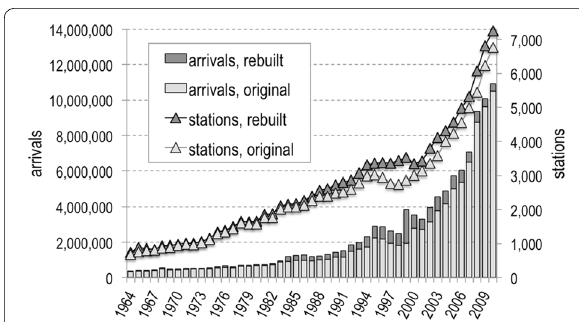
Fig. 14 The annual numbers of seismic station arrival times: original (light grey bars) and those added to the ISC Bulletin (dark grey bars) during the period 1964–2010; the total number of stations in the original (light grey triangles) and rebuilt (dark grey triangles) ISC